Question: From the figure, is the trend upward or downward?
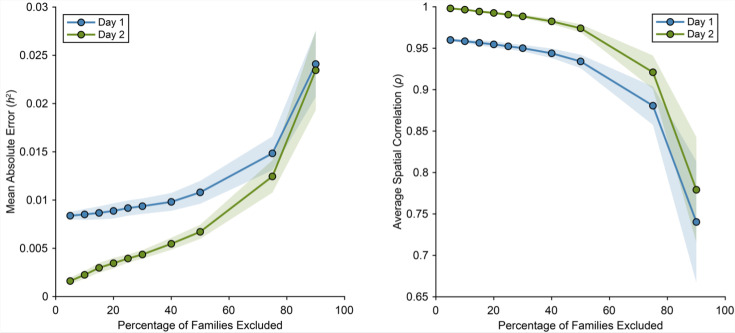
Answer: increasing